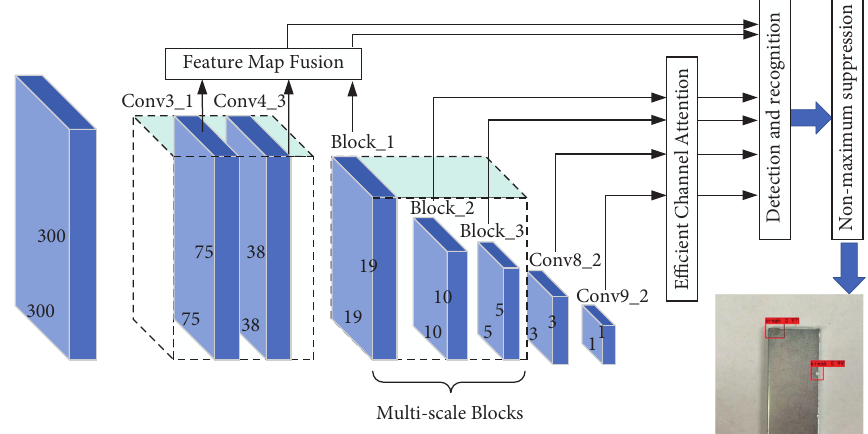
Figure 7: Improved SSD algorithm detection